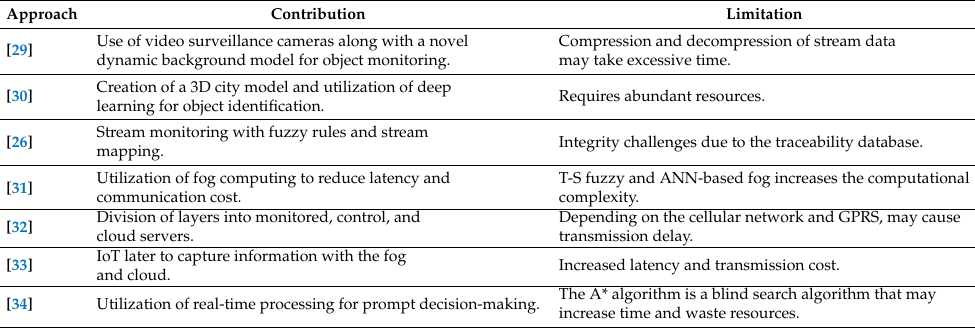
Table 1. Contributions and limitations of the existing